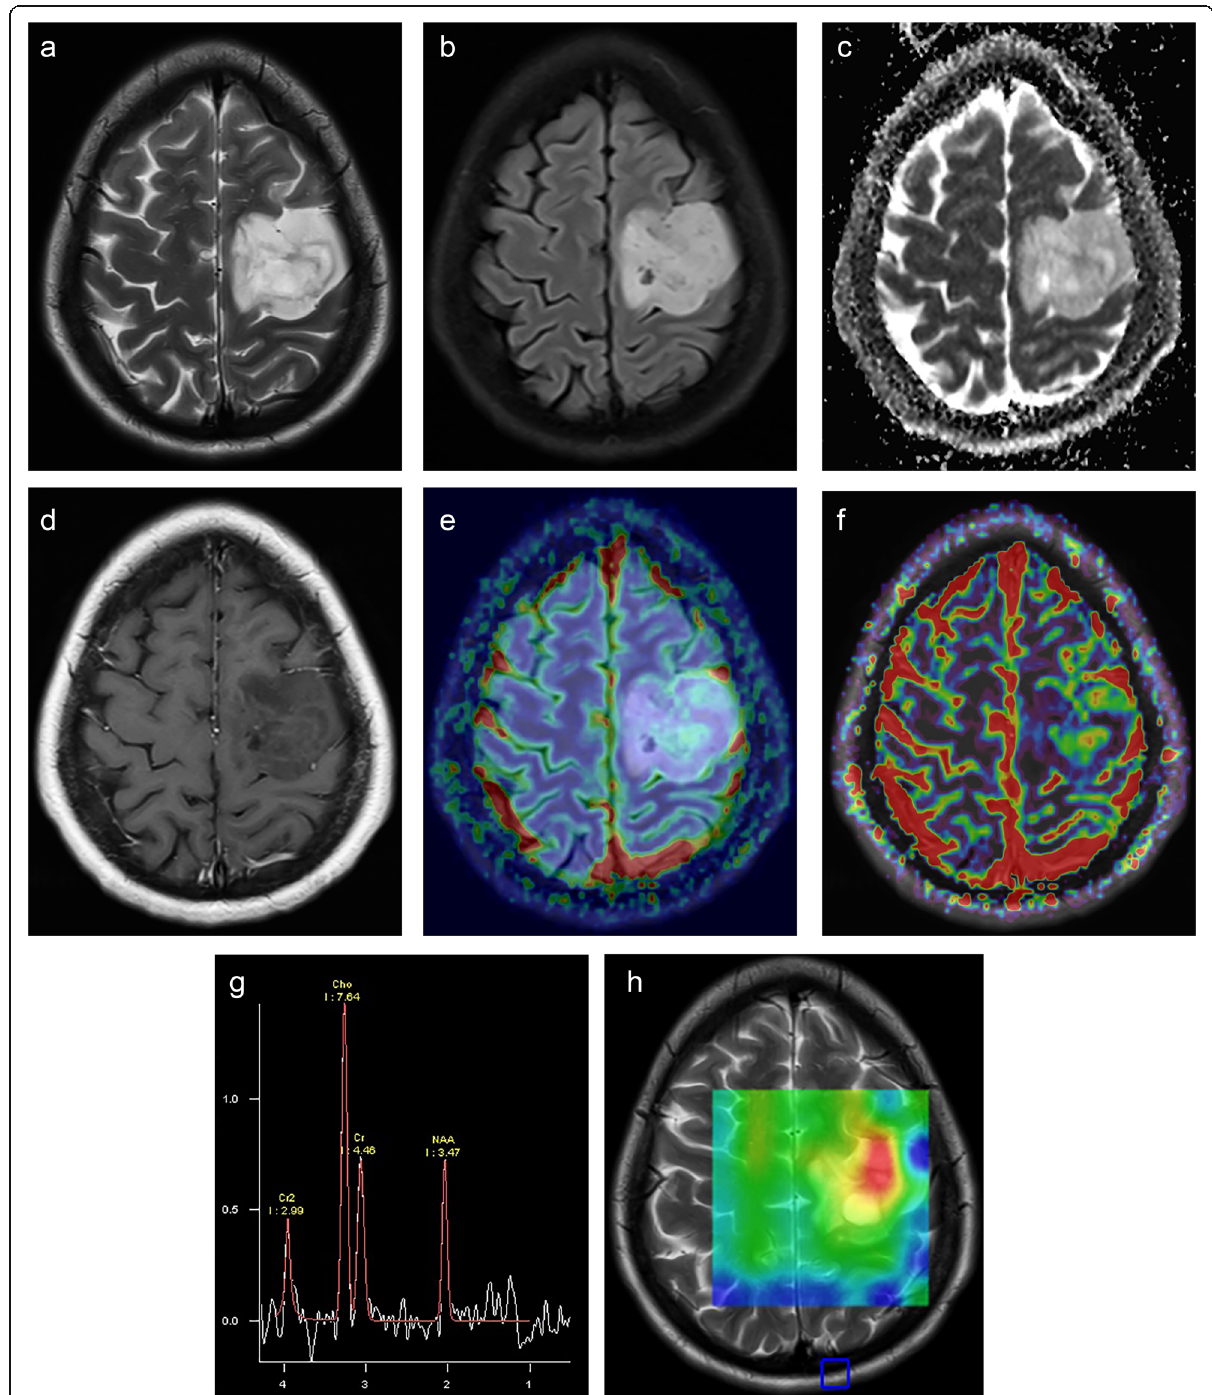
Fig. 3 Oligodendroglioma, grade II with 1p19q-codeletion, intact ATRX expression, immune-negative p53, and 2% Ki67 is located on the premotor area of the left frontal lobe on axial MR images. The irregularly contoured tumor has a heterogeneous high signal on T2 ( a ), FLAIR ( b ), and ADC ( c ) images and has a central intratumoral small low signal area consistent with calcification/hemorrhage. It has faint enhancement on post-contrast T1-weighted image ( d ). The tumor has relatively higher rCBV max values than normal parenchyma on DSC-perfusion image ( e ) and k trans values on DCE-perfusion image ( f ). The tumor has also high Cho/Cr ratio on the MR spectrum obtained by 144 ms echo time ( g ) at the similar areas of increased perfusion on colored Cho map ( h